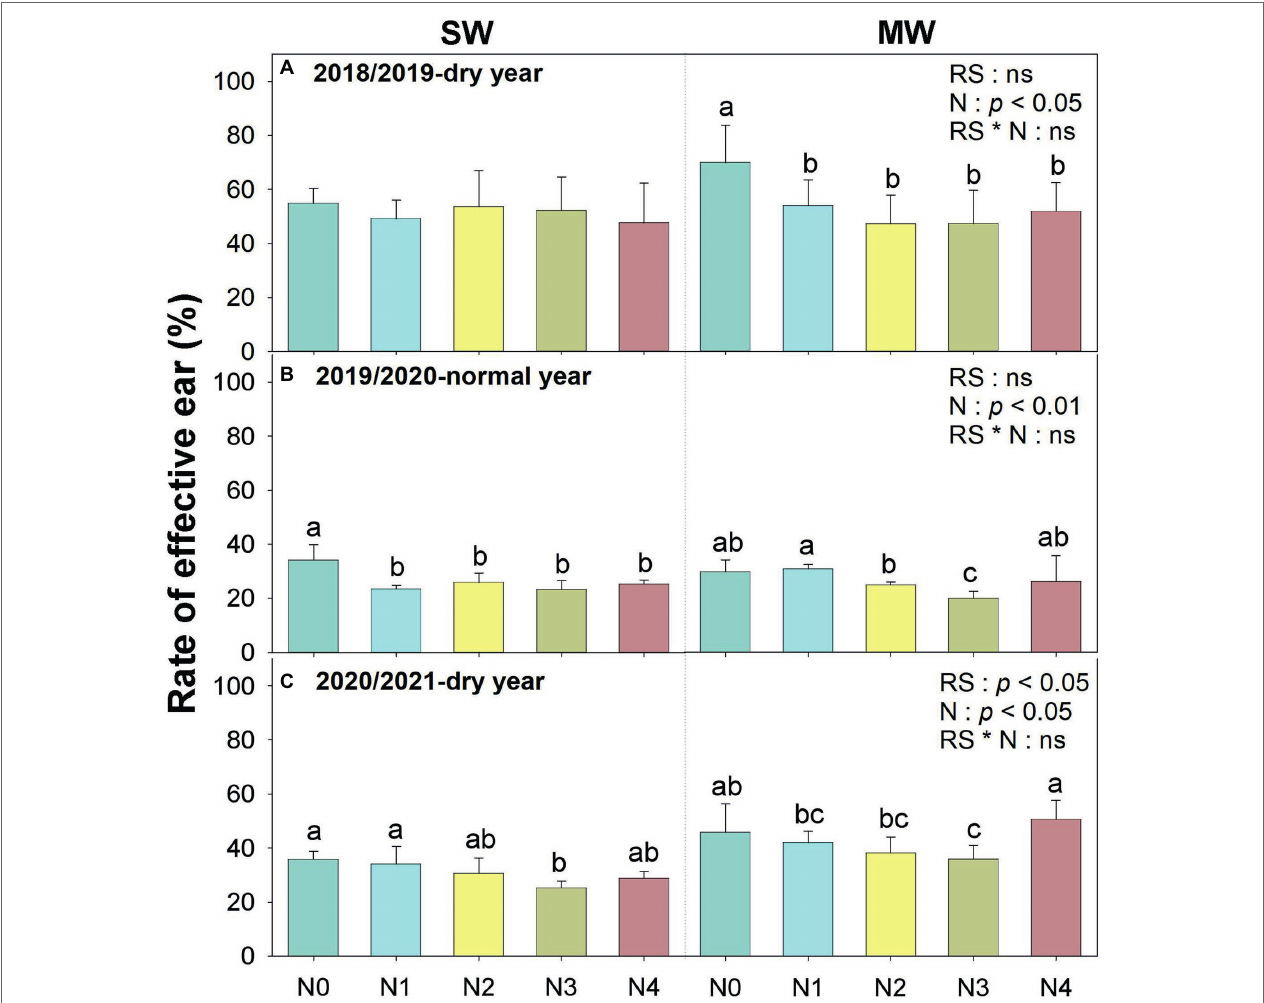
FIGURE 3 | The rate of effective ear of winter wheat in summer soybean–winter wheat (SW) and summer maize–winter wheat (MW) rotation systems under five N application rates. Values are means + SEs ( n = 3). Different lowercase letters indicate significant differences ( p < 0.05) among five fertilization treatments within the same rotation system in the same year. RS, rotation system; N, nitrogen fertilization; and CS × N, interaction of rotation system and nitrogen fertilization. N0, 0 kg N ha − 1 ; N1, 60 kg N ha − 1 ; N2, 120 kg N ha − 1 ; N3, 180 kg N ha − 1 ; and N4, 240 kg N ha − 1